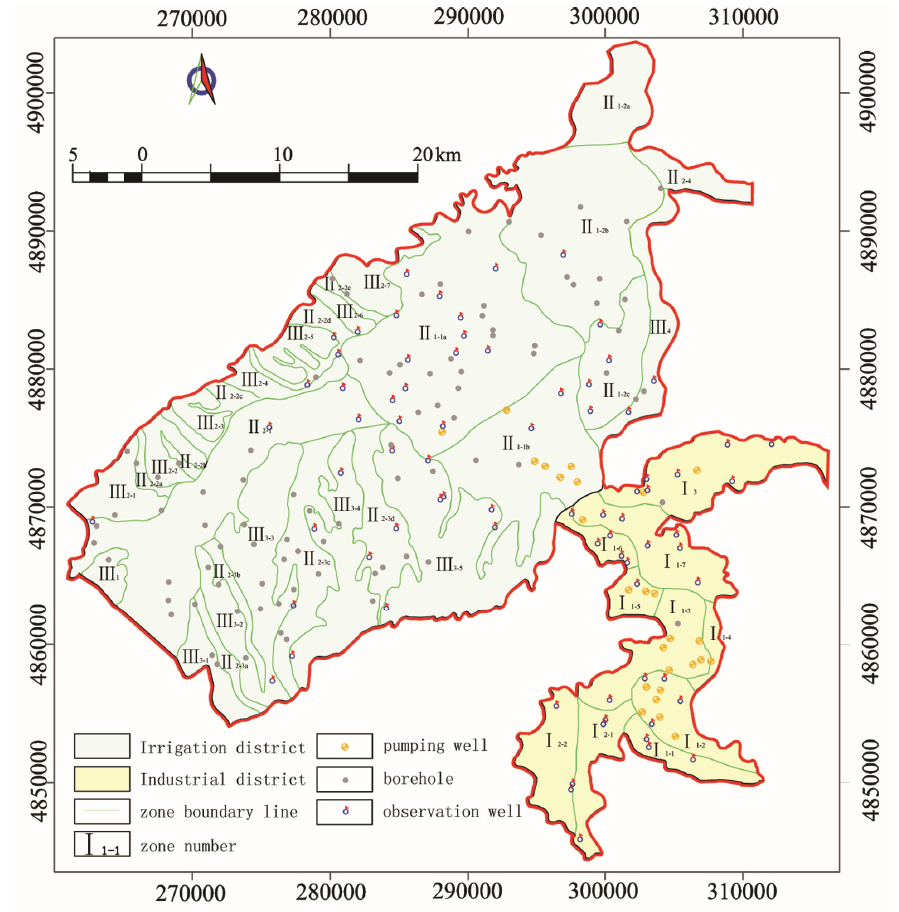
Figure 5. Location of the boreholes, observation and pumping wells and